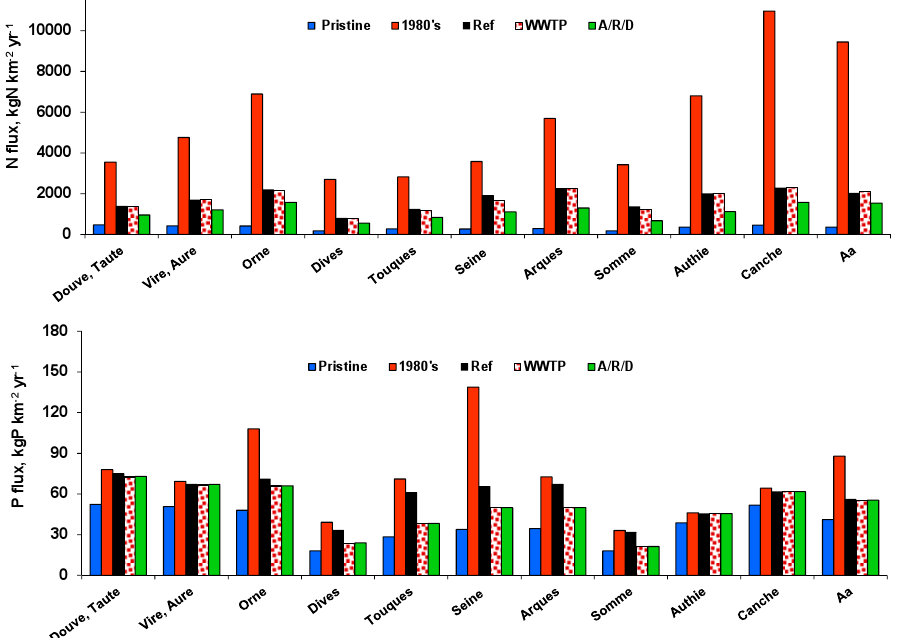
Figure 8. Average nitrogen and phosphorus fluxes delivered at the Normandy and Hauts-de-France coastlines by the main rivers in the area studied for the reference situation and for different scenarios tested, as simulated by the GRAFS-RIVERSTRAHLER model.